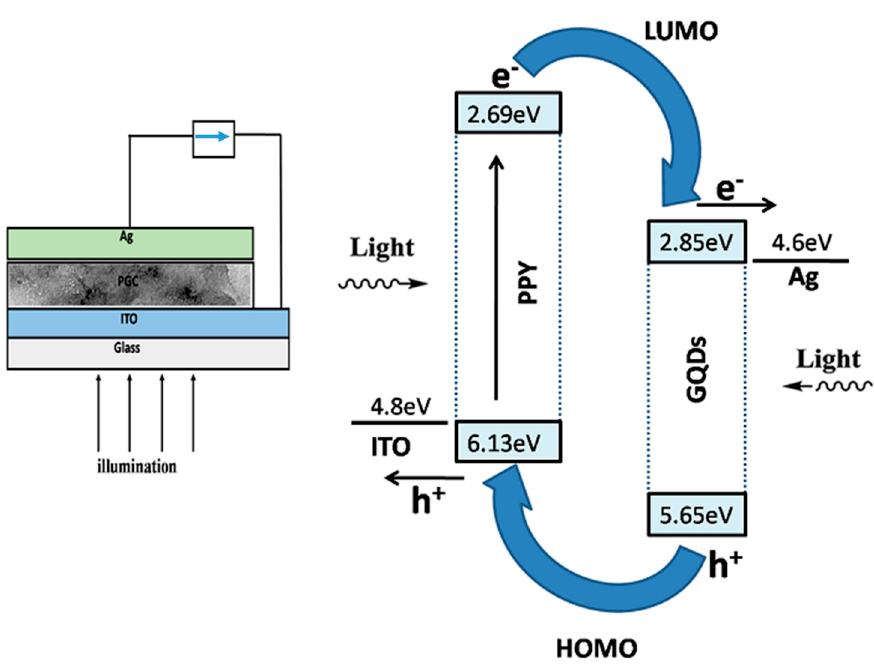
Figure 12. A scheme of photodetector device and the energy level diagram of PPY and GQDs by the illumination of light.